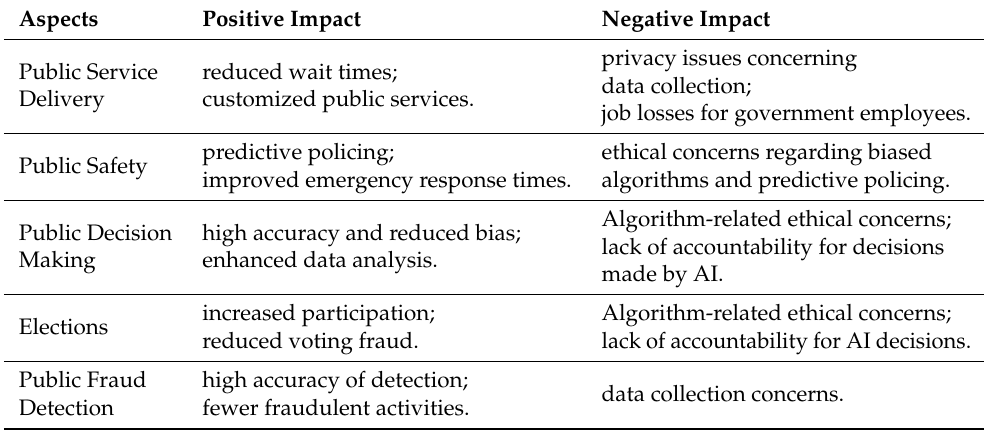
Table 15. The positive and negative disruptive effects of AI on smart government.